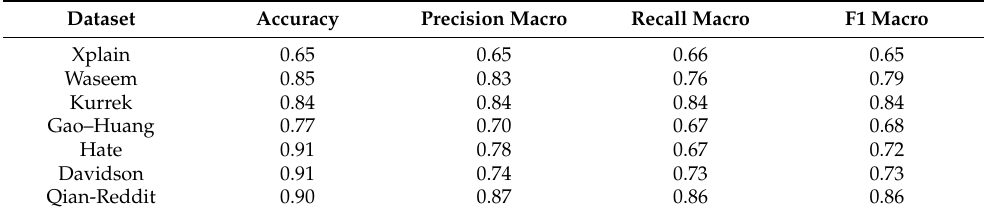
Table A7. Scores obtained on the benchmark Datasets using the bidirectional recurrent neural network layers. The embeddings were made with the help of GloVe vectors.